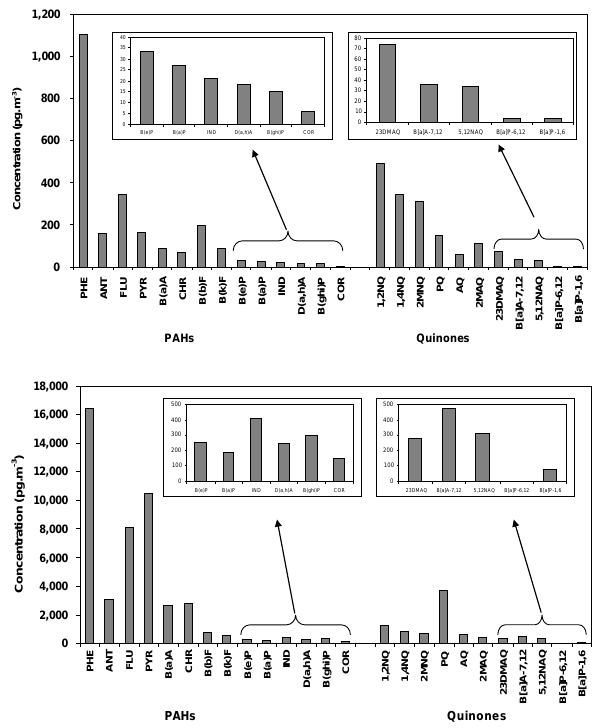
Fig. 3. Average PAH profile (sum of particulate and vapour phase) from (top graph) Weybourne and (lower graph) Elms Road Obser- vatory site (Birmingham).